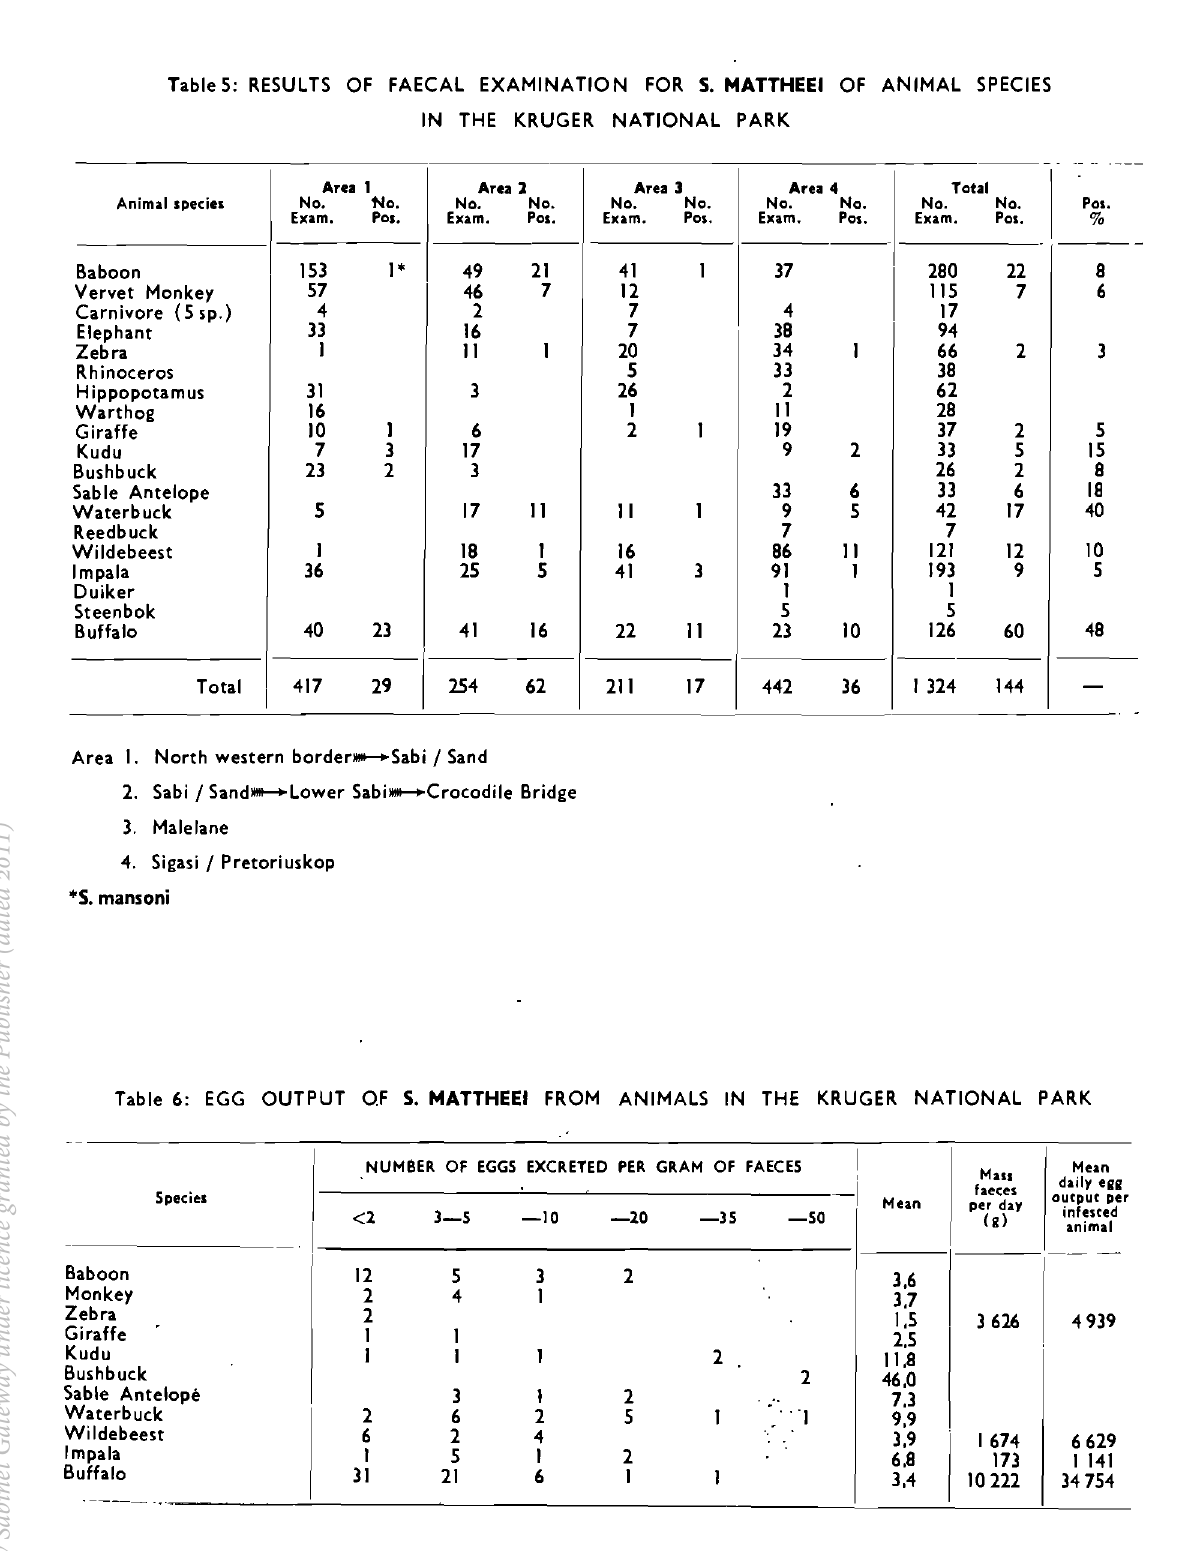
TableS: RESULTS OF FAECAL EXAMINATION FOR S. MATTHEEI OF ANIMAL SPECIES